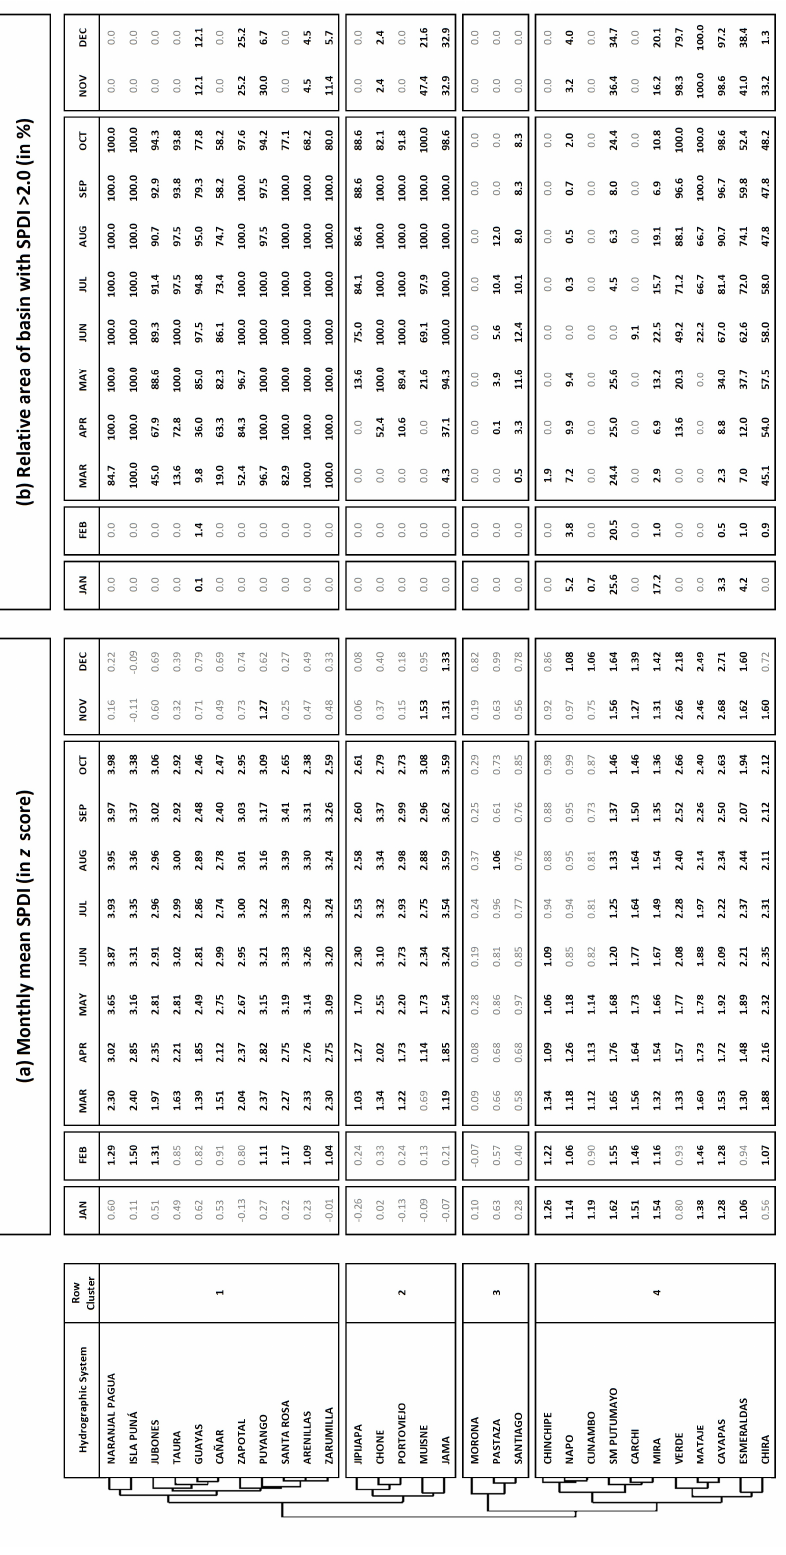
Table 2. Standardized Precipitation Drought Index (SPDI) temporal and spatial dynamics at the different hydrographic systems for 1983 (Year 2) of the mega-El Niño event EP83. Cluster analysis ( K -means clustering using Euclidean distance) was performed on both rows and columns and with the statistical tool ClustVis (Metsalu and Vilo,